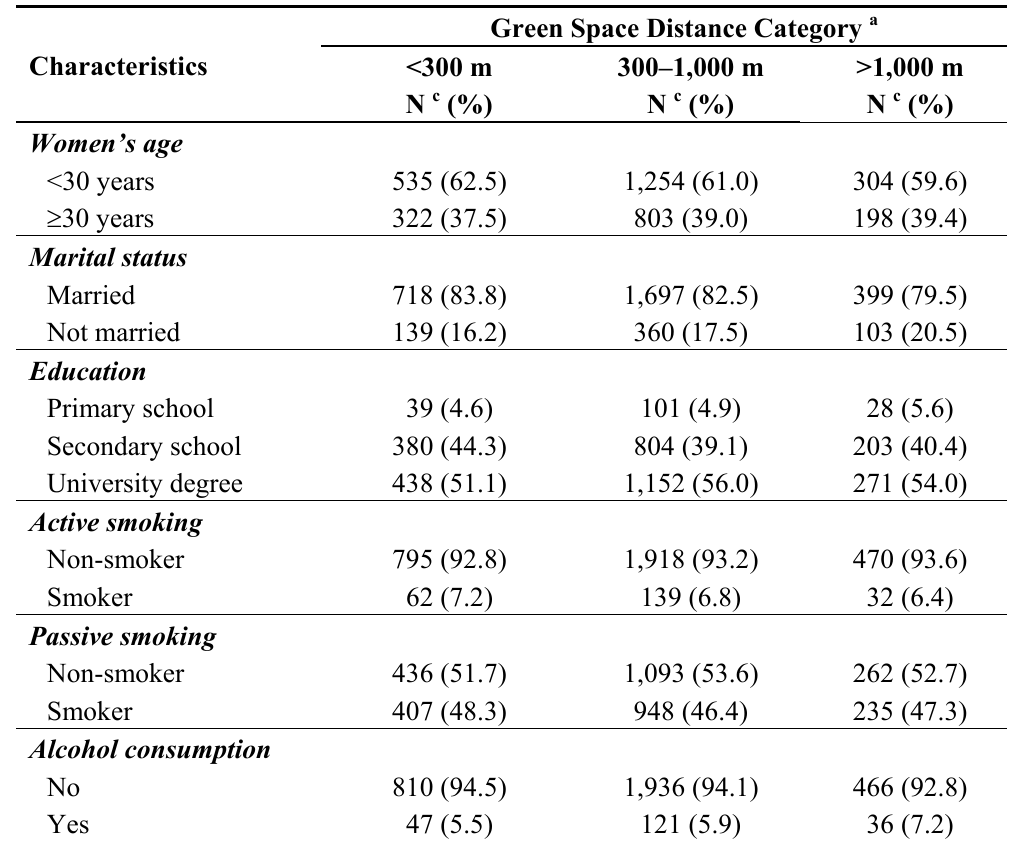
Table 2. Distribution (%) of women’s characteristics according to green space distance